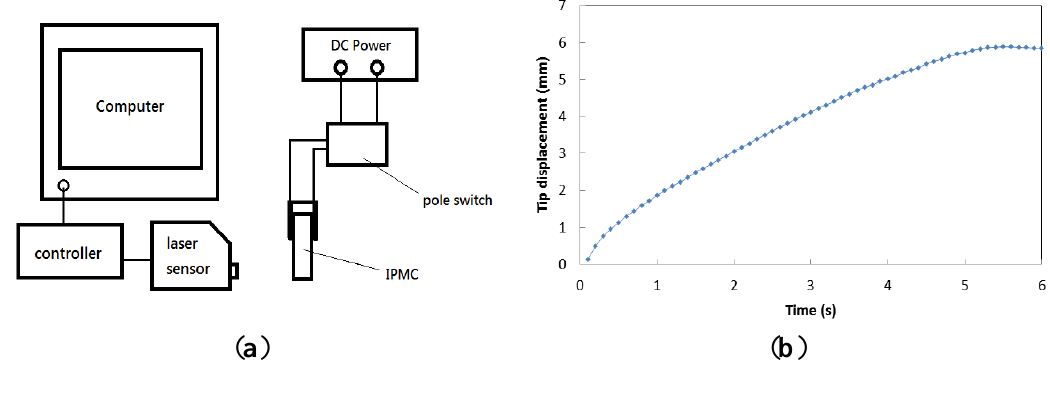
Figure 4. ( a ) Schematic diagram of tip displacement measured by laser sensor; ( b ) Diagram of tip displacement of IPMC switch versus response time at 3 V.